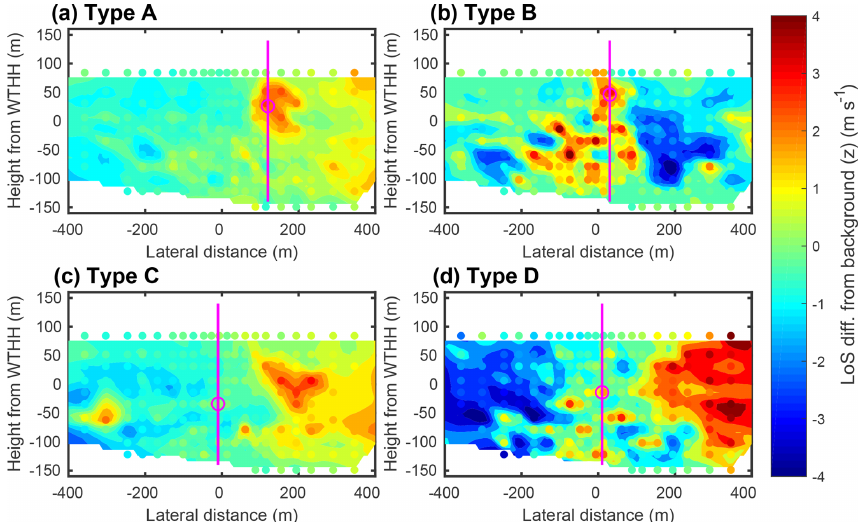
Figure 12. Representative examples of radial velocity anomalies at 2.5 D distance from the wind turbine for the four types. The scanning Doppler lidar measurements are shown as individual points, whereas the solid colours are values interpolated by cubic spline. The results of the automated wake detection algorithm are shown as magenta circle for the wake centre. To aid visibility the location of the wake centre is extended vertically as a magenta line. The wake types are as follows: A is clear wake centre, with wake location being correctly identified by algorithm, B is split wake with no well-defined centre or multiple centres, with location being correctly identified by algorithm, C is clear wake centre, with location being incorrectly identified by automated algorithm, and D means that it is not possible to identify a wake centre subjectively or automated